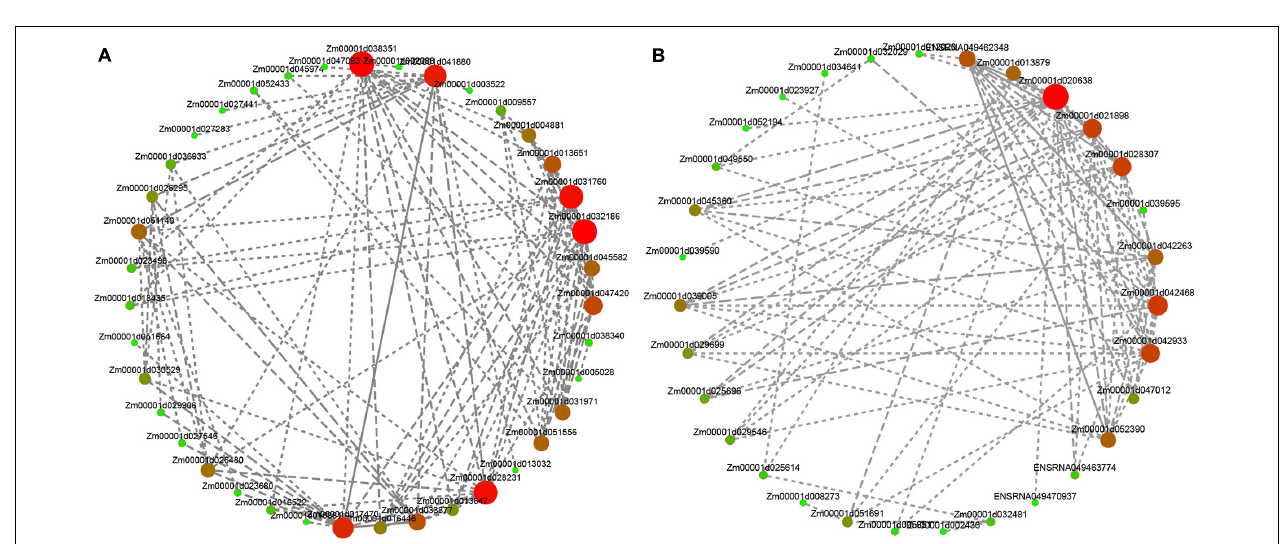
FIGURE 6 | Functional analysis of genes in the phenotypic significant enrichment module. Panels (A,B) represent GO and KEGG enrichment analysis of genes in purple module, (C,D) represent GO and KEGG enrichment analysis of genes in dark red module.